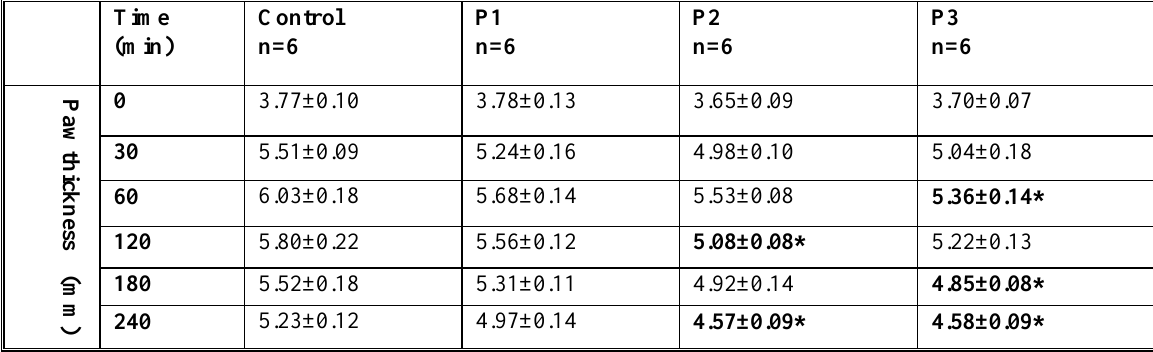
Table (2) Effect of dimethyl sulfoxide (control) and target compounds (P1-P3) on egg-white induced paw edema